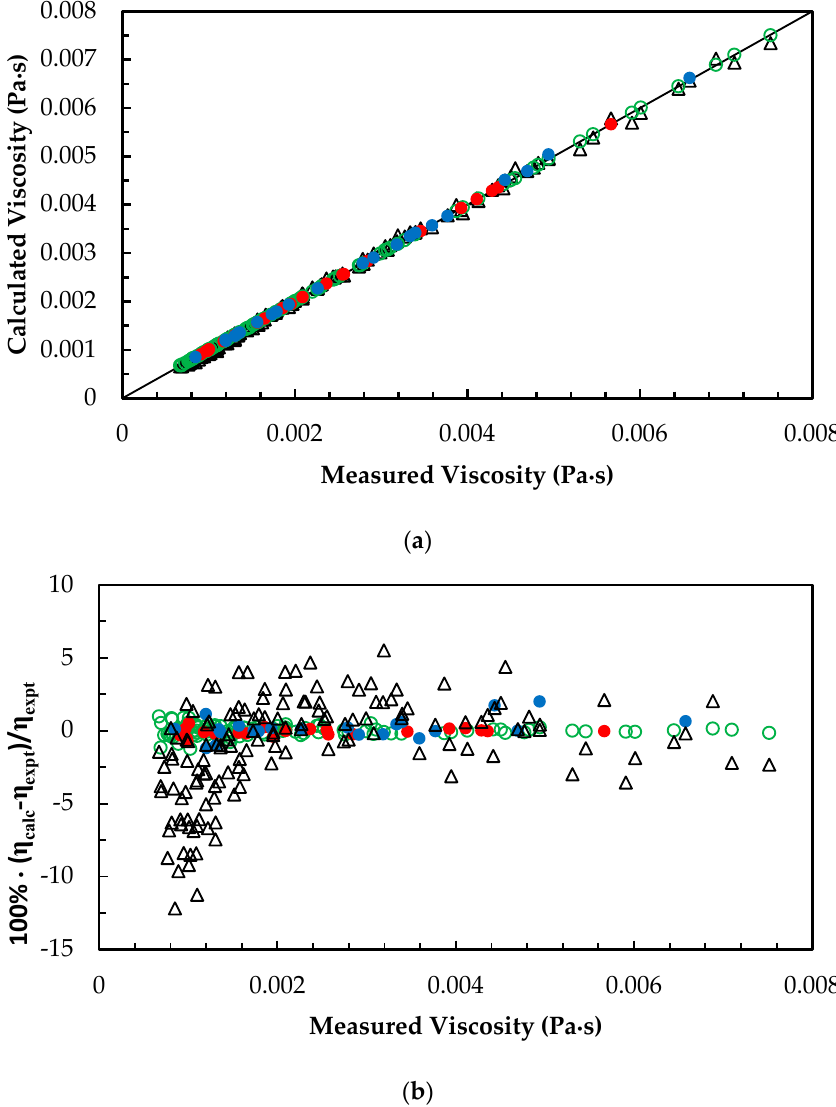
Figure 6. ( a ) Comparison of correlated density with measured density for AMP + MEA + H 2 O + CO 2 mixtures. ANN: Training data, ‘ ○ ’; Validation data, ‘ ● ’; Test data, ‘ ● ’. Modified Weiland’s correlation, ‘ ∆ ’. ( b ) Percentage deviation of correlated density from measured density for AMP + MEA + H 2 O + CO 2 mixtures. ANN: Training data, ‘ ○ ’; Validation data, ‘ ● ’; Test data, ‘ ● ’. Modified Weiland’s correlation, ‘ ∆ ’.